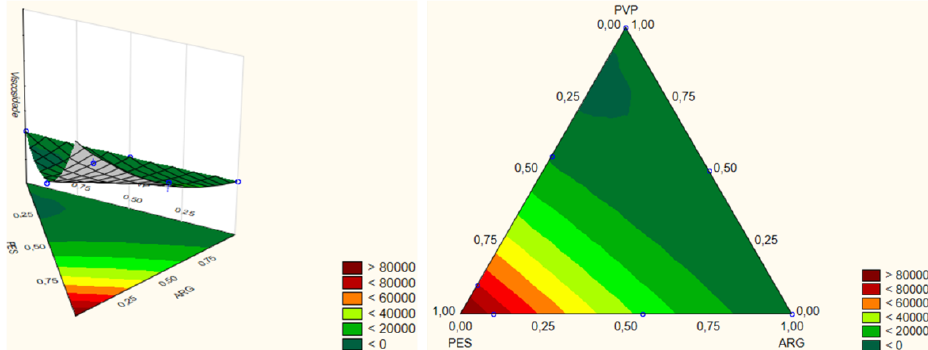
Figure 6. Response surface plot and contour plot according to the quadratic model for viscosity.